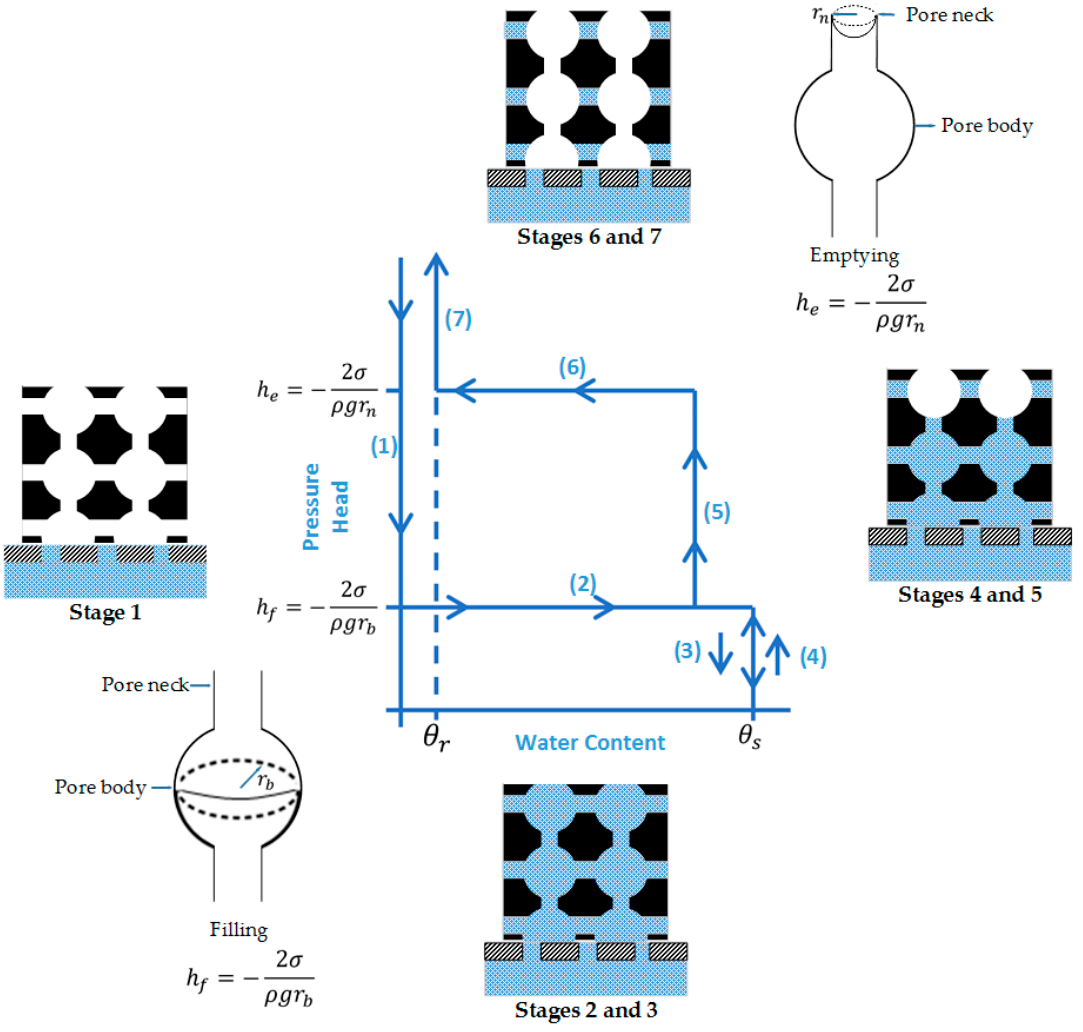
Figure 11. General understanding of “Haines jump” cycle, modified from [72].